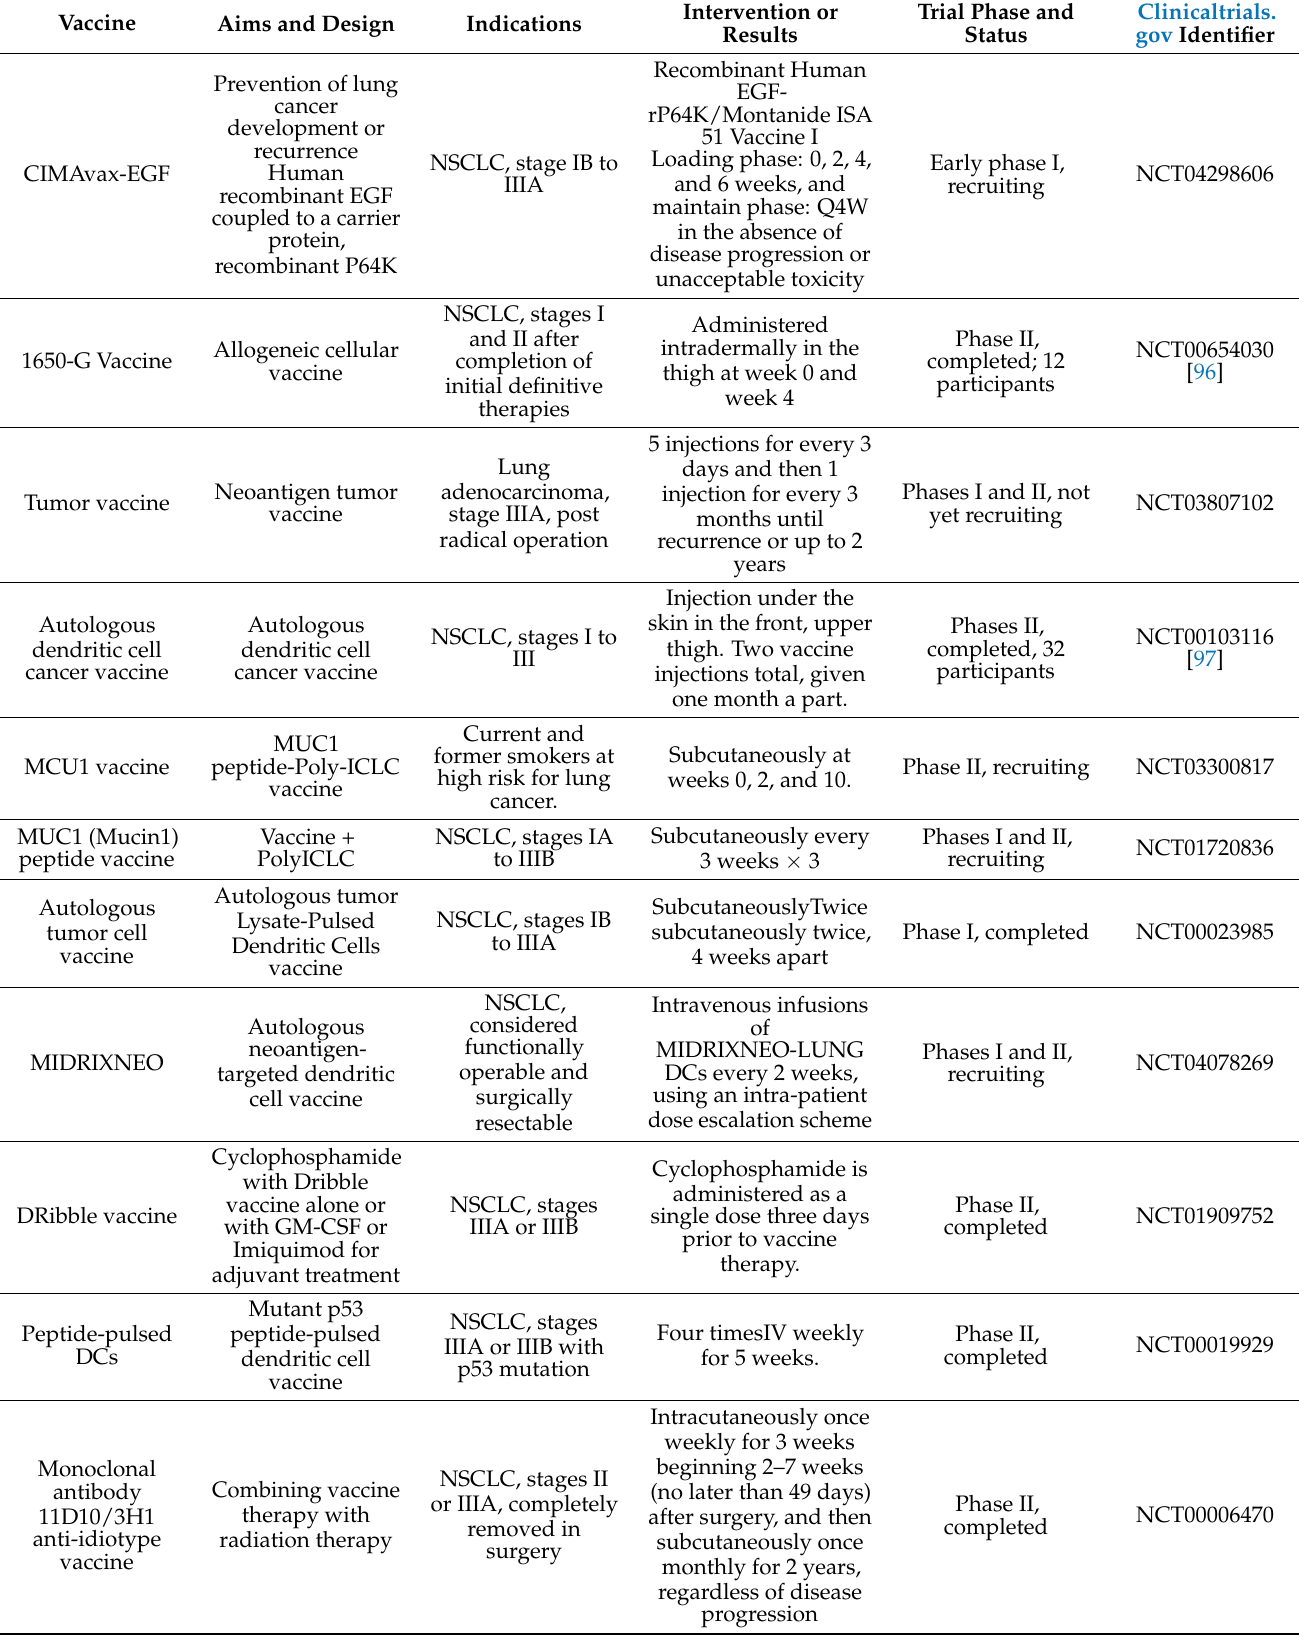
Table 5. Overview of cancer vaccination in surgically resectable, non-advanced, or preventions of non-small cell lung cancer.